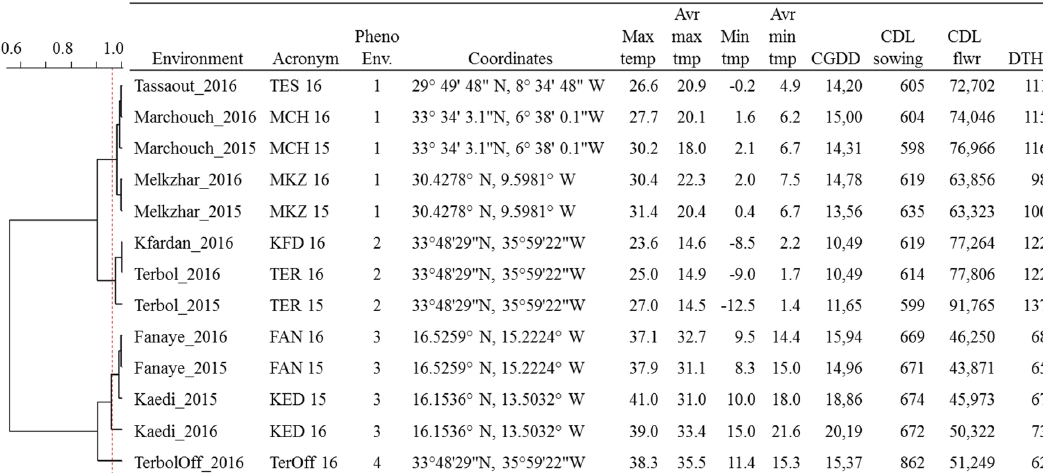
Figure 1. Distribution of ( a ) day length and ( b ) average temperature during the crop season at 13 environments including eight locations. The environments included are Kaedi (KED) 2015 and 2016 in Mauritania; Fanaye (FAN) 2015 and 2016 in Senegal; Marchouche (MCH) 2015 and 2016, Melk Zhar (MKZ) 2015 and 2016, and Tessaout (TES) 2016 in Morocco; Terbol (TER) 2015 and 2016, Kfardan (KFD) 2016, and Terbol off (TerOff) season 2016 in Lebanon. This last environment was plotted in the right axis to simplify visualization.